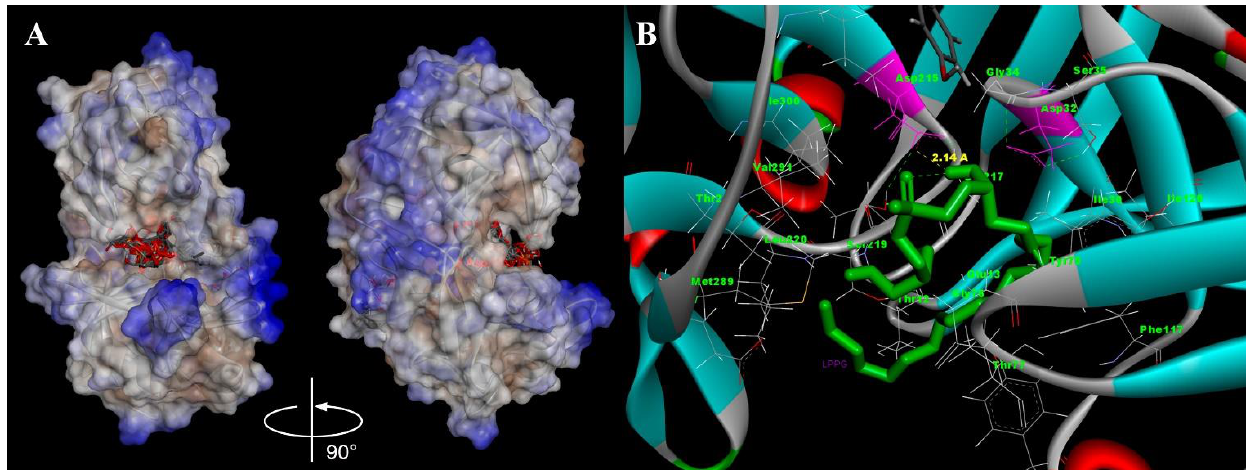
Figure 6. ( A ) Surface hydrophobicity of pepsin with 10 calculated conformations of LPPG: Asp32 and Asp215 are shown in red, hydrophilic amino acids are marked in blue, and hydrophobic amino acids are colored in brown. ( B ) Interaction of LPPG with the catalytic site of pepsin according to the molecular docking calculations: side chains of residues, contacting with the ligand, are shown with amino acid names and numbers; Asp32 and Asp215 are shown in magenta; hydrogen bonds are depicted as green dashed lines; hydrogen bond Asp215-LPPG (HO8 LPPG —Oδ1 Asp215) is shown in yellow.